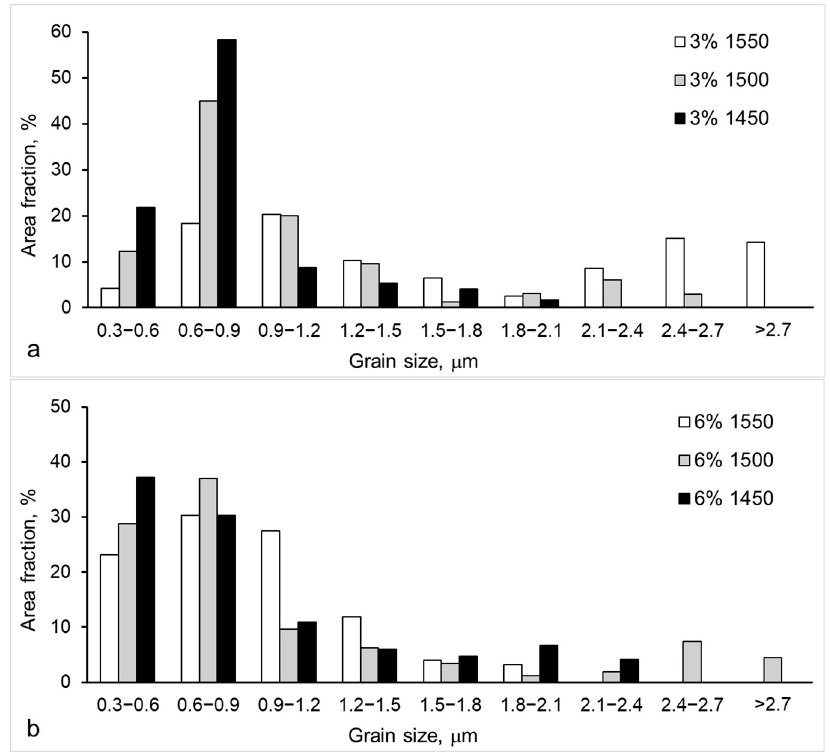
Figure 4. Distributions of grain size for ( a ) 3YSZ and ( b ) 6YSZ ceramics sintered at three temperatures.